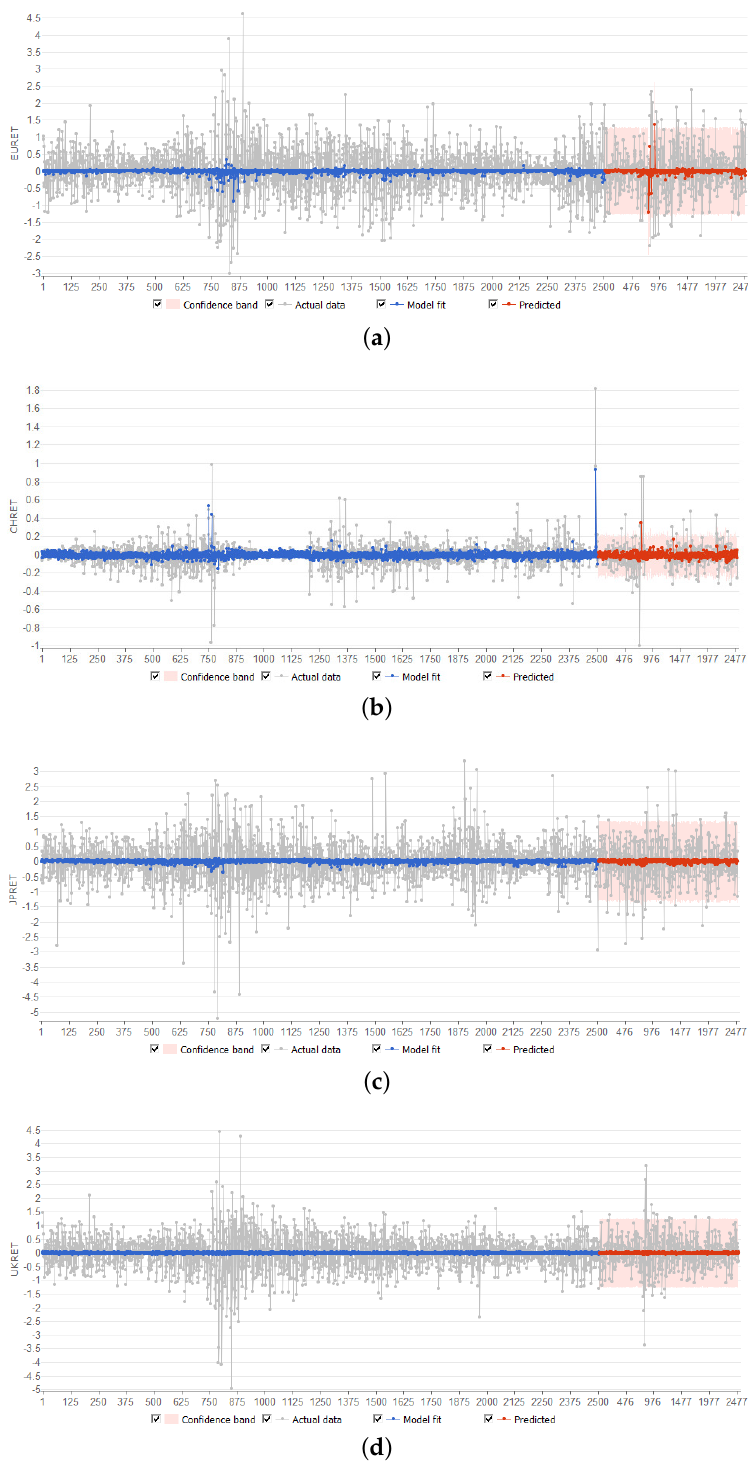
Figure 4. Model forecasts; ( a ) Euro; ( b ) China; ( c ) Japan; ( d )